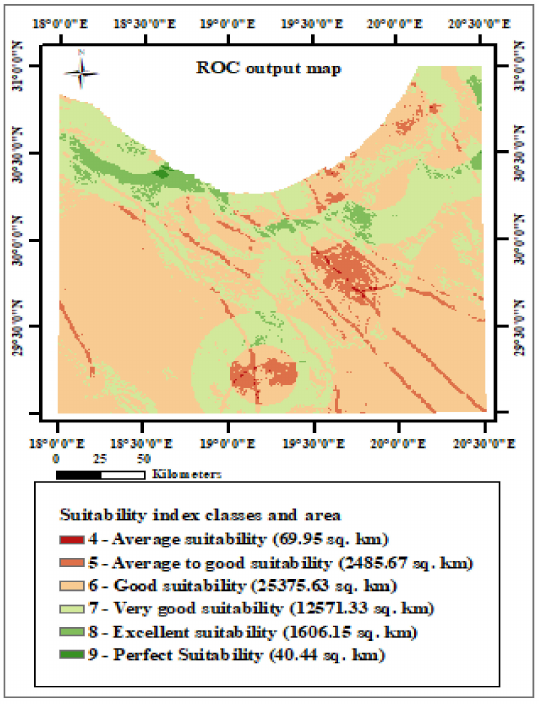
Figure 9. Output map of applying the ROC method.